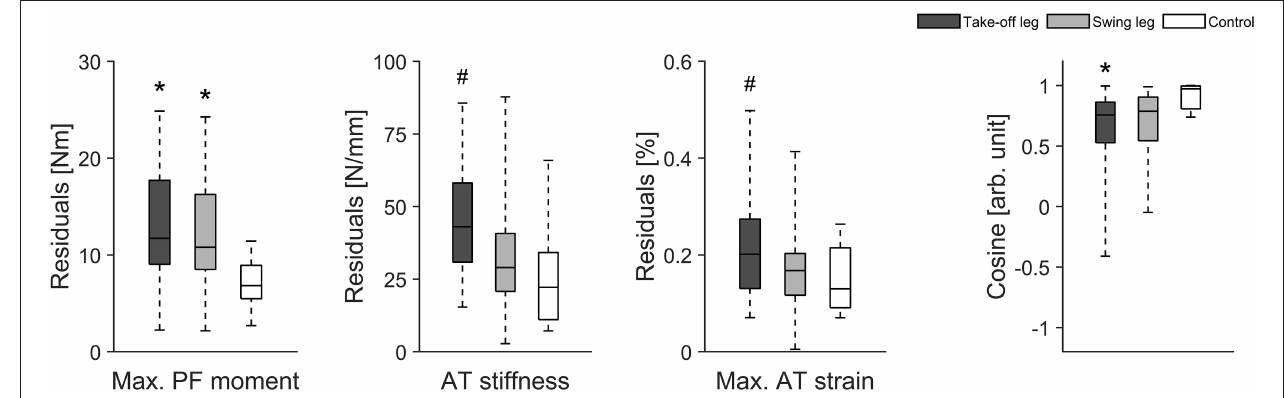
FIGURE 2 | Box plots of muscle strength (Max. PF moment), tendon stiffness (AT stiffness) and maximal tendon strain (Max. AT strain) as well as the cosine similarity (Cosine) of the relative changes of muscle strength and tendon stiffness between sessions over the 1 year observation period in 18 healthy elite jumpers (take-off and swing leg) and 12 healthy control subjects (take-off leg). *Statistically significant difference to control ( P < 0.05). # Tendency for significant difference to control (0.05 < p < 0.1).